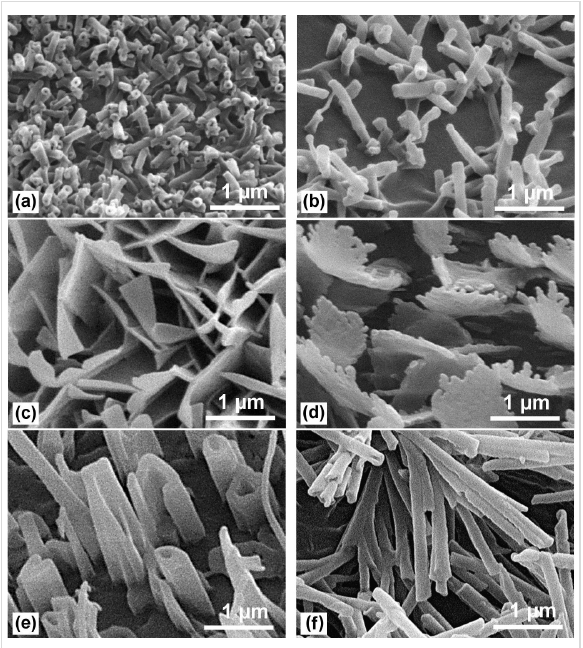
Figure 10: Epicuticular wax crystals in an area of 4 × 3 µm 2 . The upper side of the lotus leaf (a) has the highest crystal density (number per area) of wax crystals and the smallest spacings between them. Lotus upper side (a) ca. 200 tubules per 10 µm 2 ; (b) Lotus underside ca. 63 tubules per 10 µm 2 ; (c) Euphorbia myrsinites ca. 50 platelets per 10 µm 2 ; (d) Yucca filamentosa ca. 17 platelets with over 80 jags per 10 µm 2 ; (e) Brassica oleracea ca. 22 rodlets and tubules, and (f) Eucalyptus macrocarpa ca. 50 tubules per 10 µm 2 . The larger spacing between the wax crystals of the other surfaces compared to the lotus upper side is obvious.